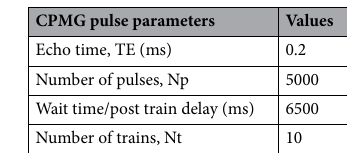
Table 1. Optimal CPMG pulse sequence parameters for detection of fast relaxing clay-bound water and heavy oil signals.